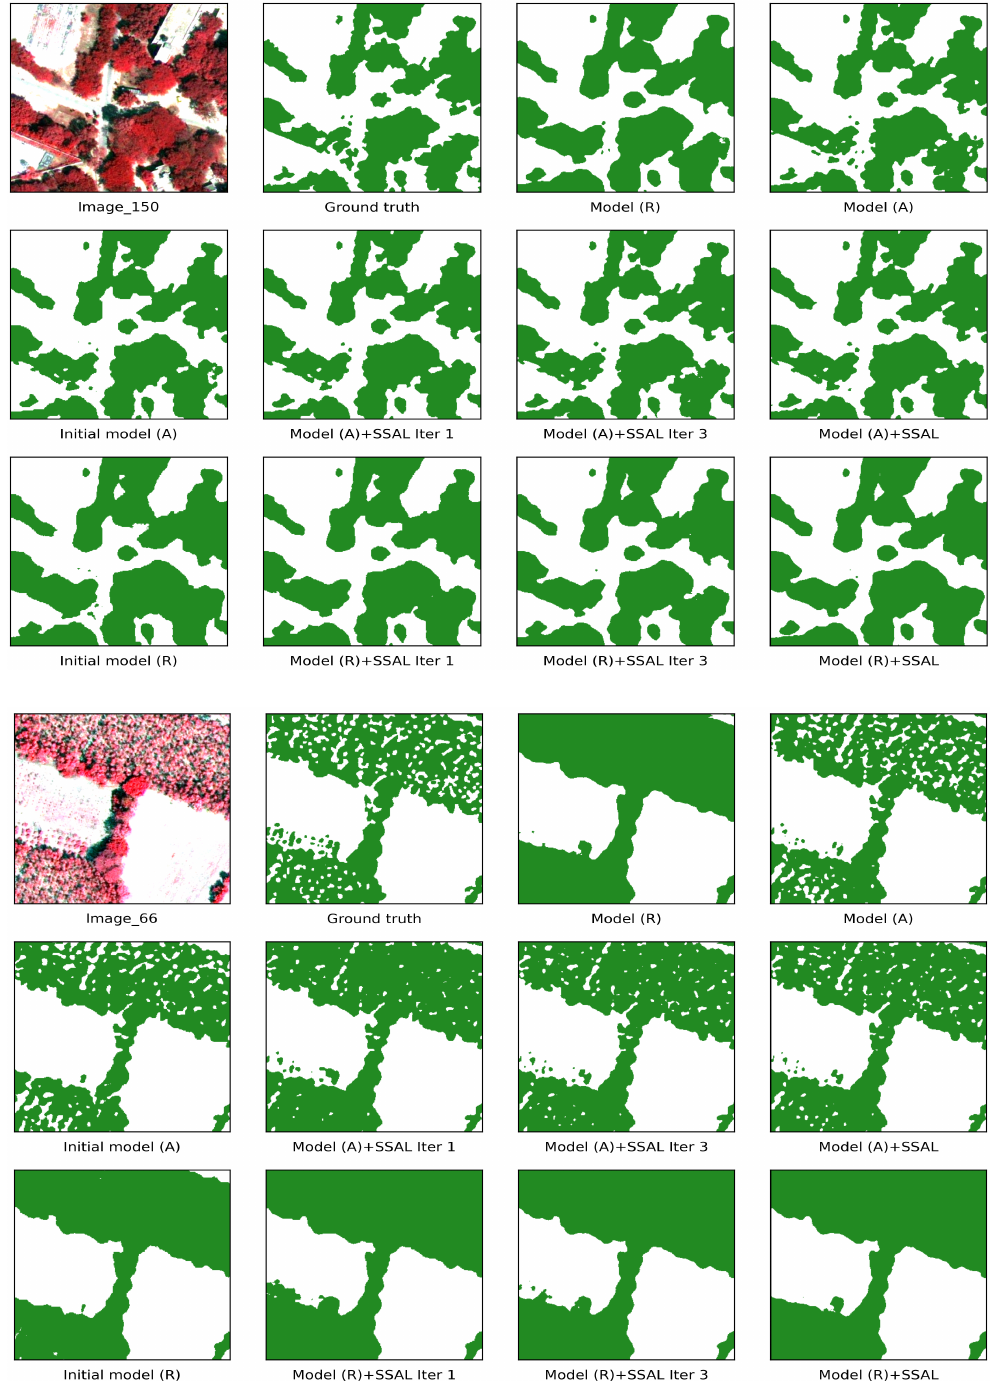
Figure 6. Classification results of two test images. For each test image, the subplots in the first row, from left to right, depict the false color image (near IR1, red and green), the ground truth, the segmentation results of models trained on roughly (R) and accurately (A) delineated masks. The subplots in the second and third row represent the classification results of the initial model, the model with intermediate iterations (Iter1 and Iter3) and the final iteration when applying semisupervised active learning (SSAL) on datasets with accurately and roughly delineated masks,